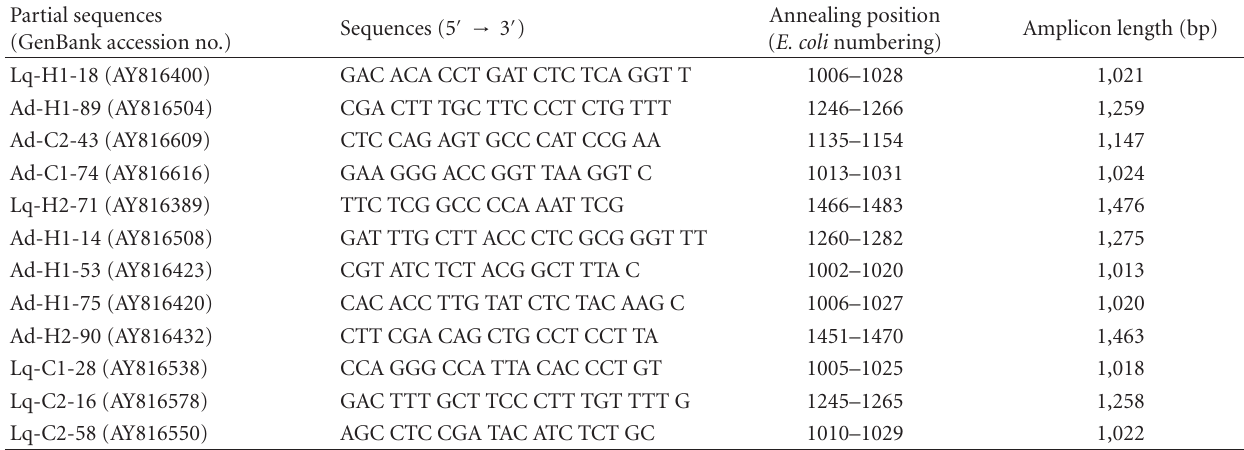
Table 1: Primers ∗ used to retrieve full-length rrs gene sequences of the uncultured bacteria. Partial sequences